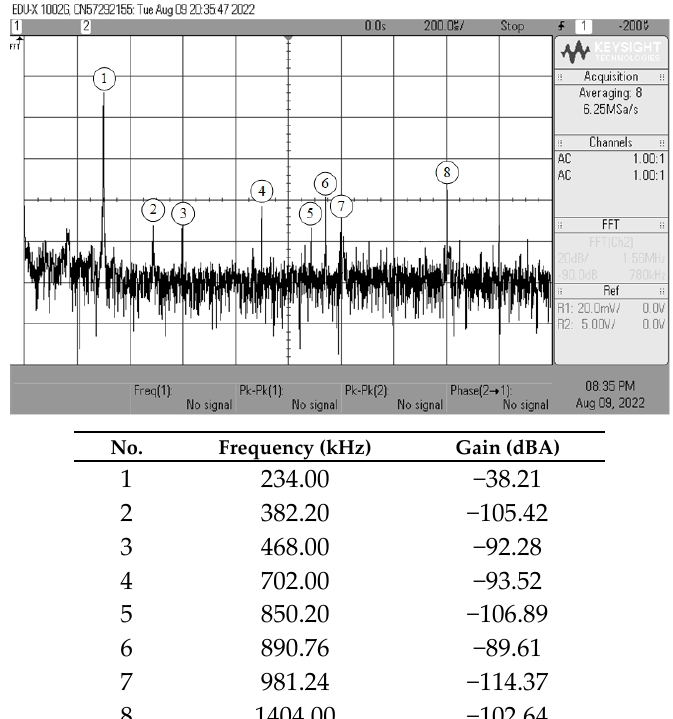
Figure 19. Experimentally observed frequency spectrum of i o(CM) of the AP filter in CM.